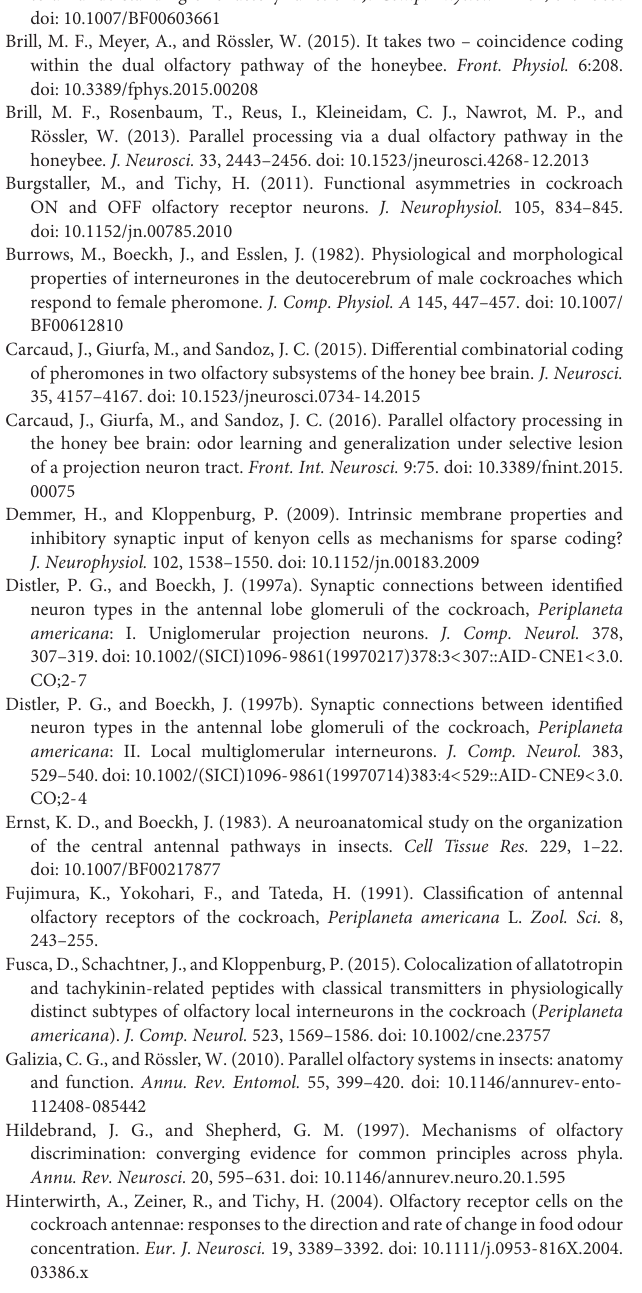
FIGURE S3 | Cluster analysis of temporal activity patterns elicited by cineol. Based on PSTHs during the 1-s cineol stimulations, we classified 84 PN responses into four response clusters. The four response clusters are arbitrarily grouped based on the cluster dendrogram (left panel, height 30) formed by Ward’s method and PSTHs. The heat map shows PSTHs with a bin of 20 ms, and the heater color represents the higher spike activities within the bin. Red and green circles represent the responses from type1 and type2 PNs,